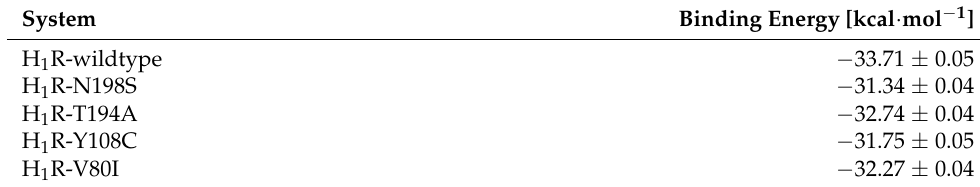
Table 2. Interaction energies between doxepin and the H 1 receptor. Averages and standard deviations ( n = 5000 frames) were calculated using MM/GBSA. Values are averaged over two independent simulation runs for each